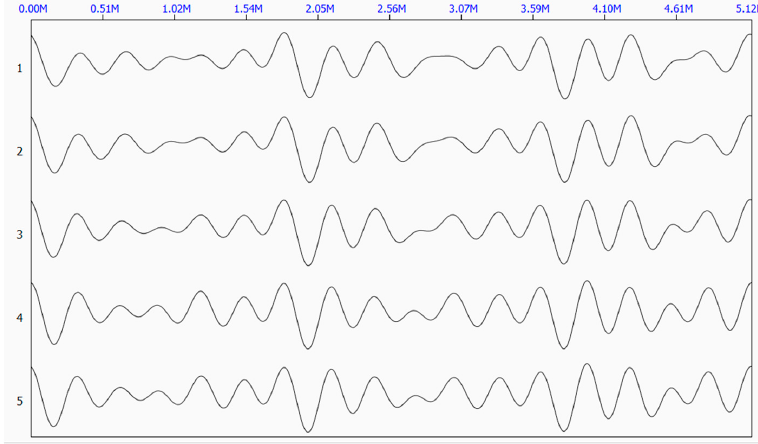
Figure 6. Original waveforms of the reflected stress wave.